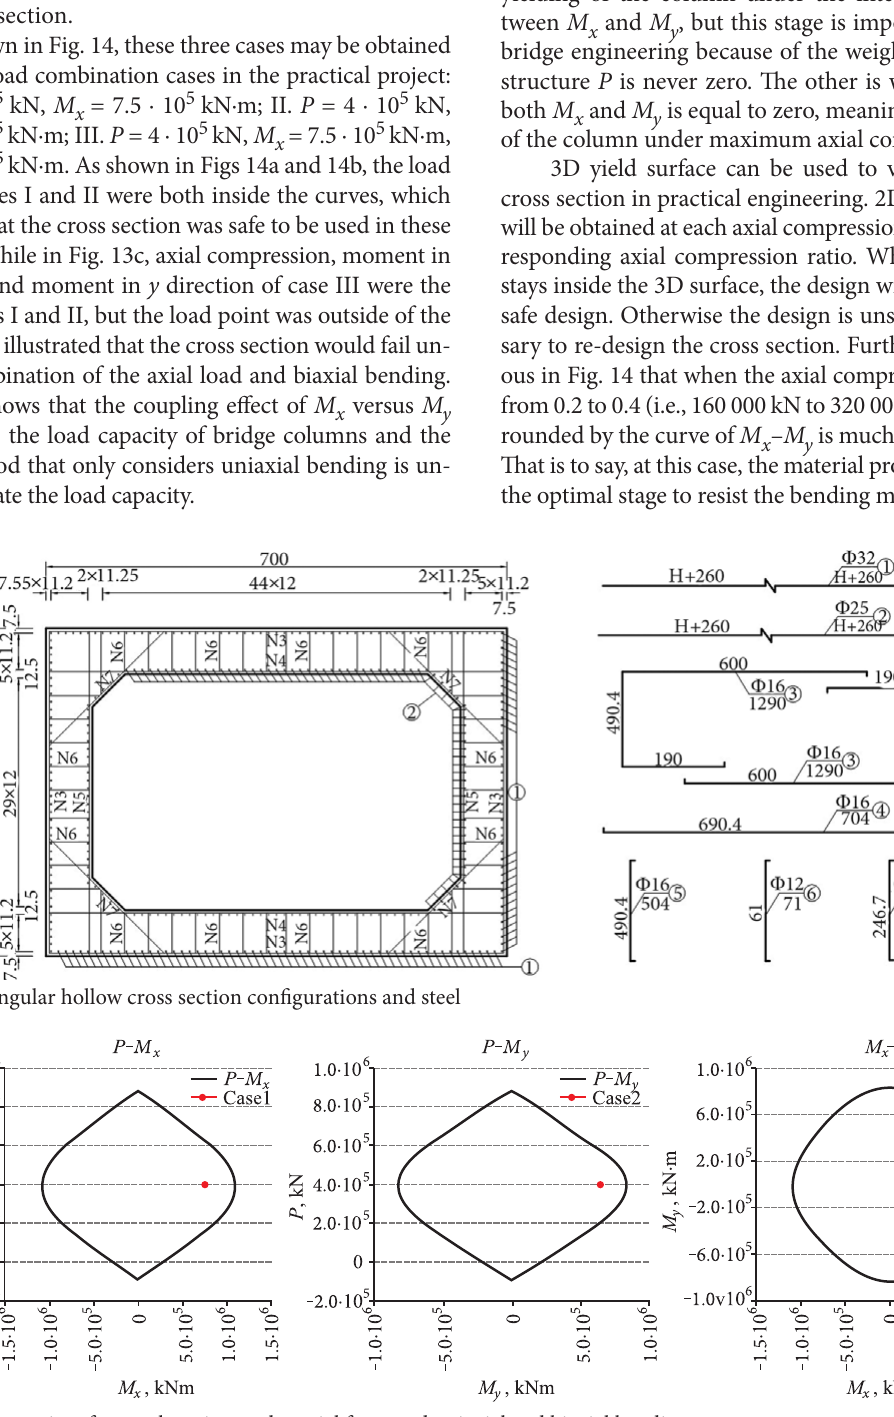
Fig. 14. Load capacity of control section under axial force and uniaxial and biaxial